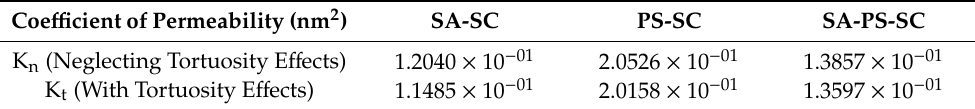
Table 4. Permeability results from mercury porosimetry (with and / or without tortuosity e ff ect).